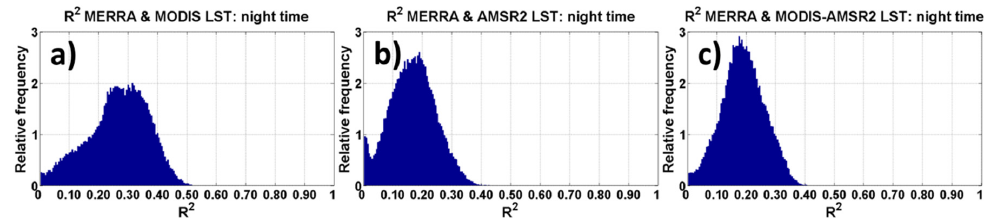
Figure 6. Histograms that show the agreement between the anomalies from MERRA Land Surface Temperature and the remotely sensed Land Surface Temperature products from MODIS ( a ); AMSR2 ( b ) and through the presented combination approach ( c ) expressed in R 2 .